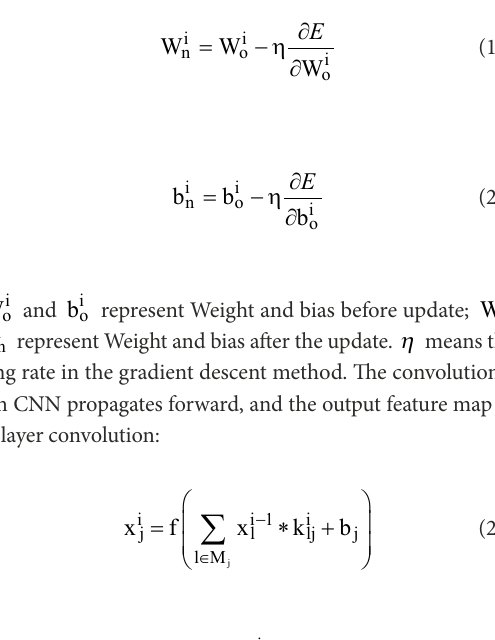
activation functions. The activation function is to activate neurons to reduce the probability of overfitting. Commonly used activation